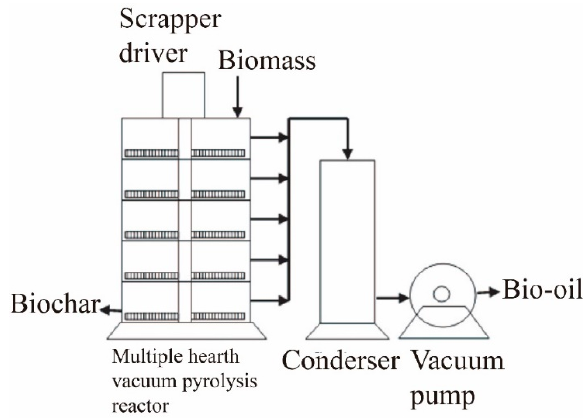
Figure 10. Schematic for the vacuum pyrolysis reactor.